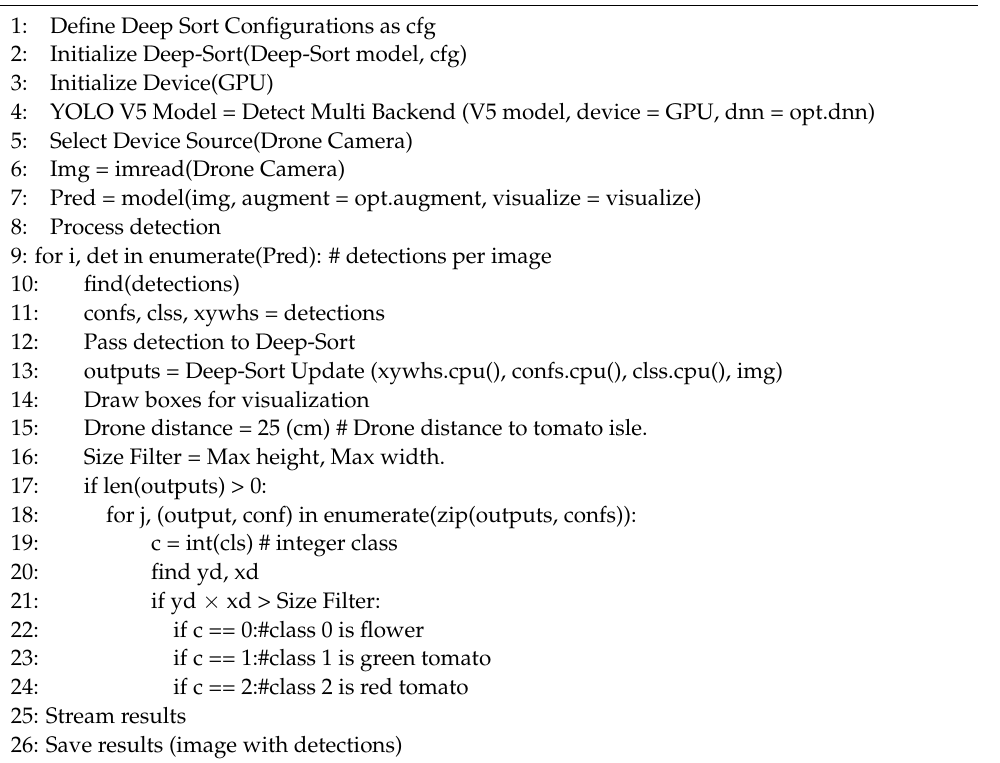
Algorithm 2: Inspection and Counting Algorithm using distance